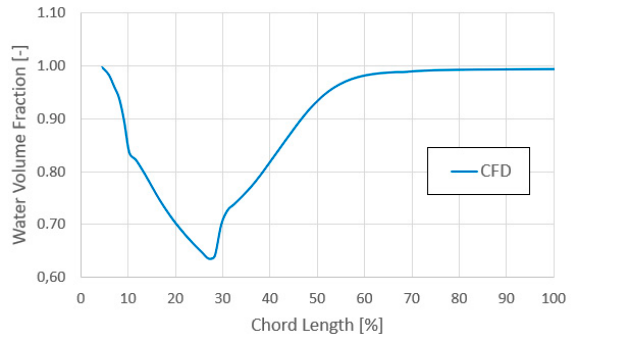
10 of 21 Figure 11. Comparison of numerical and experimental results on upper side of hydrofoil, σ = 1.9. ( a ) Distribution of water volume fraction; ( b ) temperature difference related to the first thermistor probe position. To verify the adjusted empirical cavitation parameters, the other experiments and numerical simulations were conducted for the cavitation number σ = 1.83. With this cavi- tation number, the cavity is located behind the first thermistor probe but extends to the